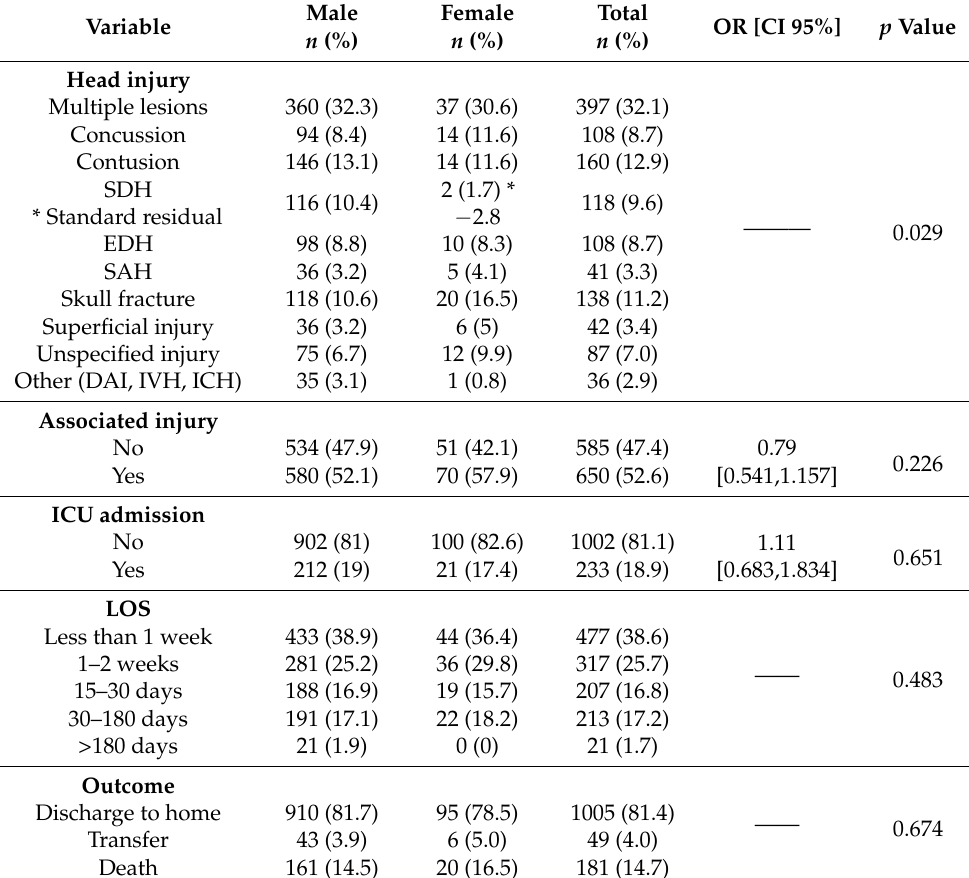
Table 2. Pattern of head injuries and its outcomes by gender ( n = 1235).